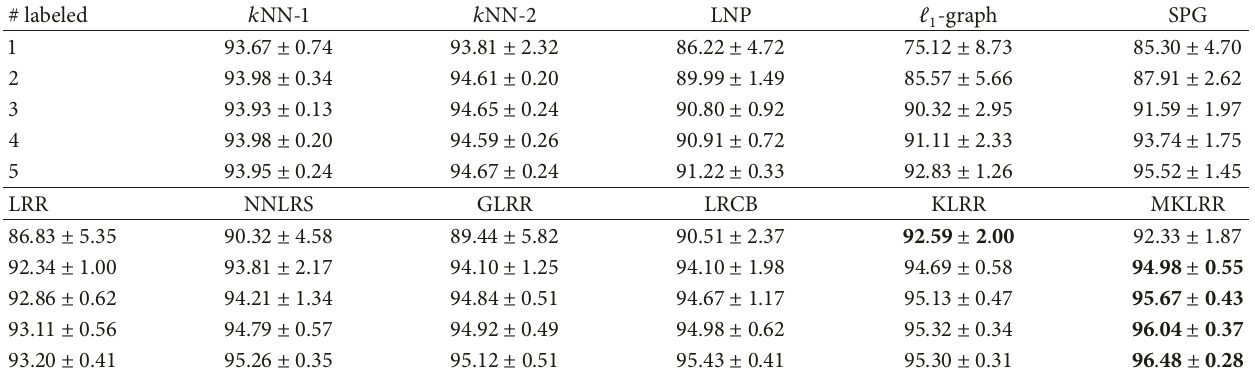
Table 1: Classification accuracies (%) of different graphs on synthetic data